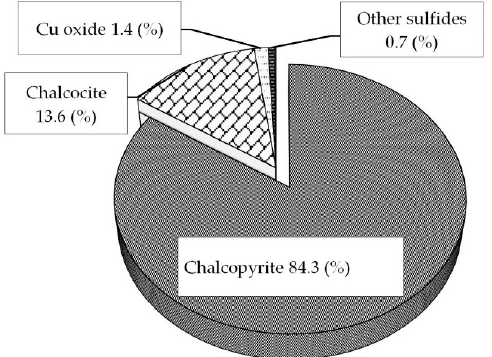
Figure 1. Mineralogical distribution of the copper-bearing sulfide minerals in the ore (amount in wt% and 100% base copper species). Table 1. Mineralogical composition of the ore obtained by QEMSCAN analysis Mineral Amount (wt %) Chalcopyrite 0.62 Chalcocite/digenite 100 Figure 2. Particle size distribution of the chalcopyrite ore used in the column leaching tests. ( a ) col- umns 0.45 m high and ( b ) columns 1 m high. 2.2. Bacterial strains and growth conditions An ore residue collected from a copper dump-leaching plant in Chile was loaded into a 0.45 m high column and irrigated with 4.5 K medium consisting of (NH 4 ) 2 SO 4 (2.0 g/L), K 2 HPO 4 (0.25 g/L), MgSO 4 ·7H 2 O (0.25 g/L), KCl (0.10 g/L), and FeSO 4 ·7H 2 O (22 g/L)